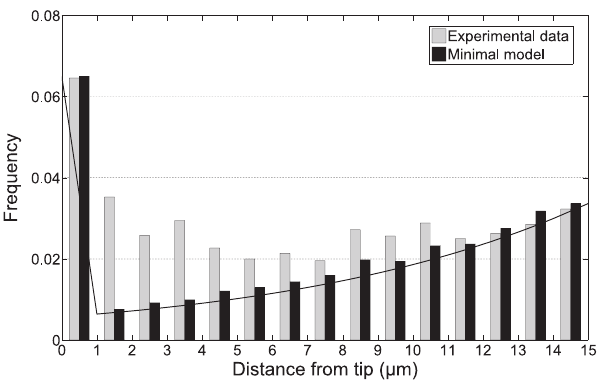
Figure 4. Comparison of tip-to-branch distribution at small distances between minimal model and experimental data at 80 m m trim. Analytic prediction is also shown (curved line).